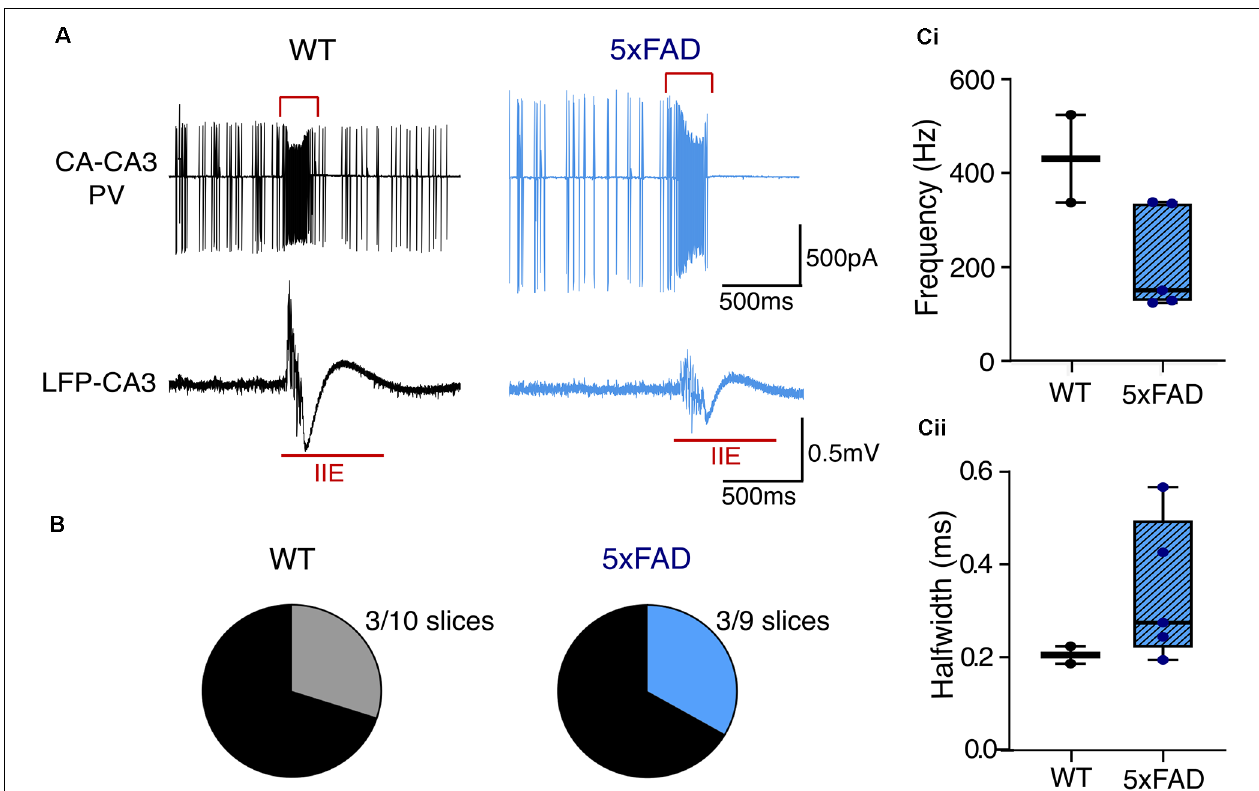
FIGURE 7 | Ictal-like activity patterns in 5xFAD and control slices during kainate application. (A) Representative traces from brain slice recordings in kainate that developed ictal-like activity. The top traces show the cell-attached PVIN recordings, and the bottom traces show the simultaneously recorded LFP during an inter-ictal event (shown in red)—the red square bracket in the PVIN recording indicates the section used for the analysis of spike properties during the IIE. (B) The total number of slices in submerged configuration from older WT and 5xFAD mice that displayed interictal-like activity. WT: n = 10 slices, three mice (zero female); 5xFAD : n = 9 slices, three mice (two females). (C) Boxplots of the PVIN firing frequency (Ci) and spike halfwidth (Cii) during the IIEs, from a subset of recordings which displayed both interictal activity and PVIN spiking. WT: n = 2 slices, one male mouse; 5xFAD: n = 5 slices, three mice (one female). The median is shown by the black line and the boxed region indicates the interquartile range with the range shown by the whiskers [Data in (C) Mann-Whitney U